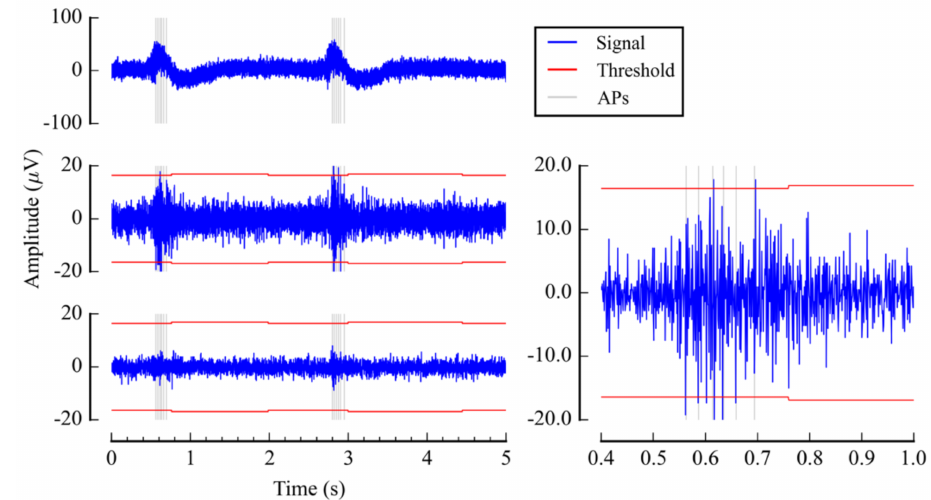
Figure 10. Detail of real-time AP detection on a neuron culture using an adaptive threshold and Haar wavelet filtering. Signals shown are: A: raw signal and AP detection; B: 4th wavelet transform level on which detection was performed, detection threshold, AP detection; and, C: 1st wavelet transform level, on which the detection threshold was computed, detection threshold, and AP detection. The experimenter visually validated detected